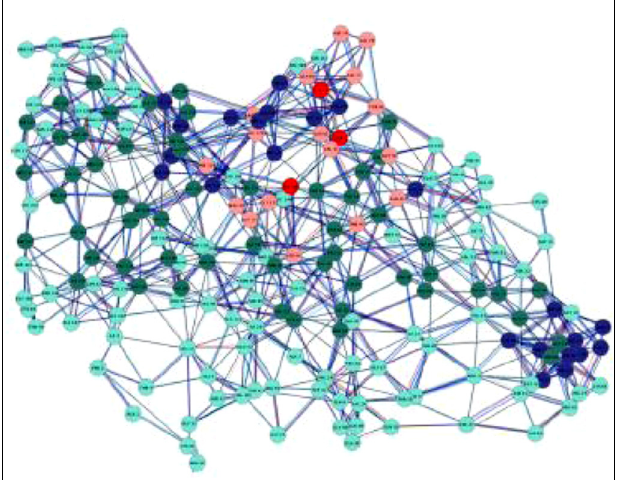
FIGURE 2 | A protein contact network (PCN): this is a complex graph in which each node corresponds to an aminoacid residue and each edge to a physical contact between two residues. The nodes are variously colored according to aminoacid chemico-physical features (Di Paola etal., 2013).The chemico-physical features can be made to correspond to the Tellegen’s constitutive laws, while the wiring pattern has an autonomous